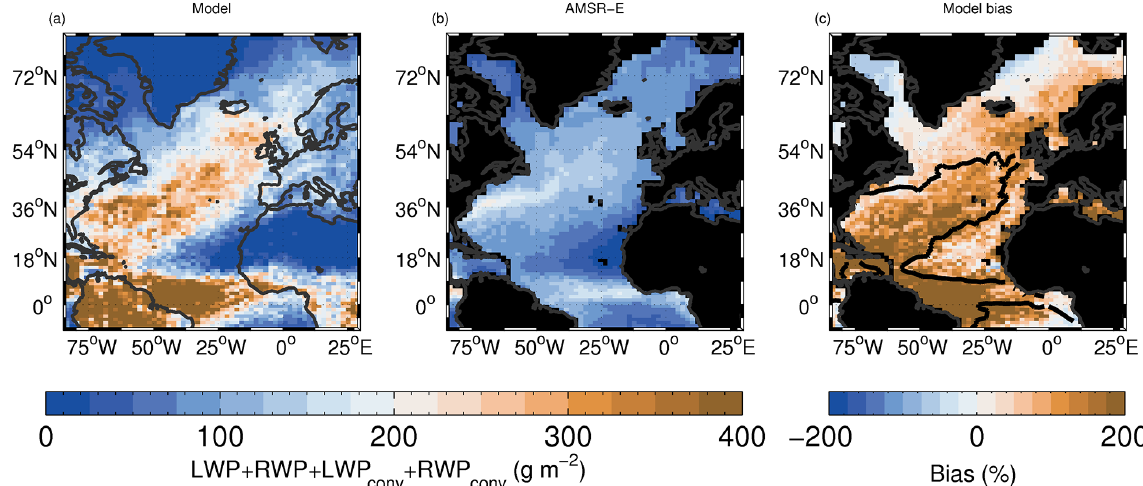
Figure D6. As for Fig. D5 except with the addition of the all-sky RWP from the convection parameterization of the model.